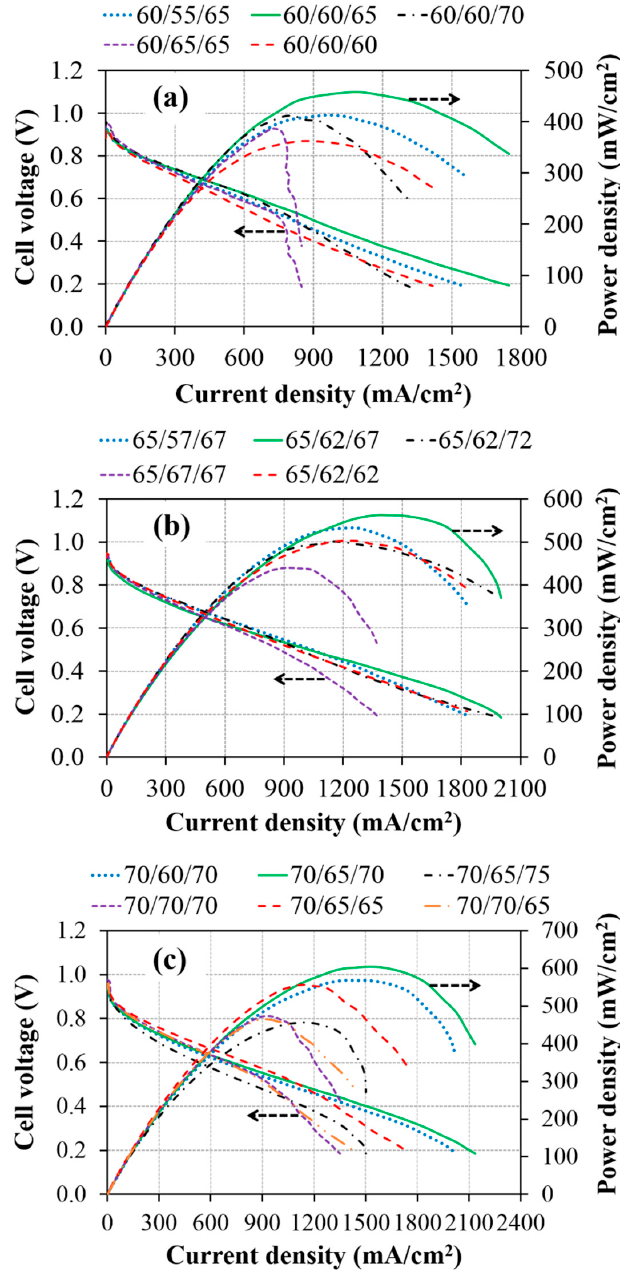
Figure 4. Polarization and power density curves of AEMFCs operated at cell temperature of ( a ) 60 °C, ( b ) 65 °C, and ( c ) 70 °C with different dew points of the anode/cathode inlet gases (the symbol of 60/55/65 denotes that the cell temperature and dew points of the anode and cathode are 60 °C, 55 °C, and 65 °C, respectively).